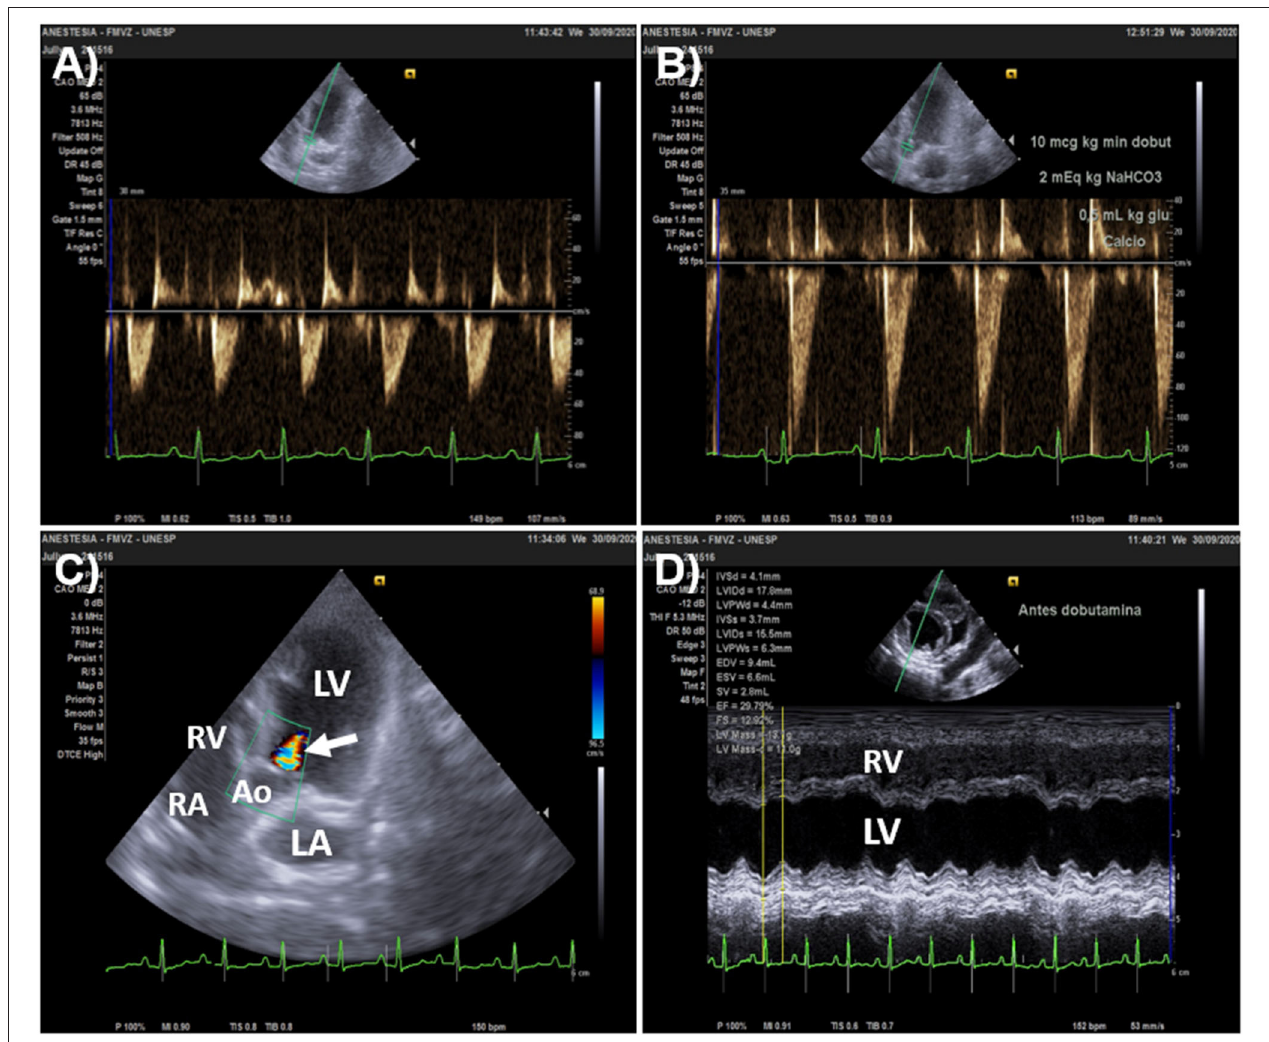
FIGURE 5 | Overestimation of stroke volume (SV) changes by aortic flow velocity-time integral (VTI) in a 3.0kg Pinscher dog that presented aortic regurgitation. The animal was admitted with signs of acute circulatory failure (unconsciousness of sudden onset, absent peripheral pulses and muffled heart sounds). (A) Baseline heart rate (HR) and aortic flow VTI (left parasternal, five-chamber apical view) was 149 beats/min and 5.1cm, respectively. Doppler systolic arterial pressure (SAP) was undetectable. The minute distance (HR times VTI) was 760cm. (B) After dobutamine was administered by constant rate infusion (10 µ g/kg/min), HR was 113 beats/min and aortic flow VTI increased by 100% (from 5.1 to 10cm); while minute distance and SAP were 1113cm 170 mmHg, respectively. (C) The 100% increase in VTI detected after dobutamine overestimated percent increases in SV because of a significant aortic regurgitation shown by color Doppler (arrow). (D) M-mode echocardiography of the short axis of the heart (right parasternal view) upon admission showed that ejection fraction (EF) and fractional shortening (FS) were 29.8 and 12.9%, respectively, denoting severe systolic dysfunction (defined as EF < 40% and FS < 20%). Inotropic support was initially chosen to increase SV and cardiac output instead of fluid challenge administration in this animal because of severe left ventricular systolic dysfunction. Ao, aorta; RV, right ventricle; RA, right atrium; LA, left atrium; LV, left